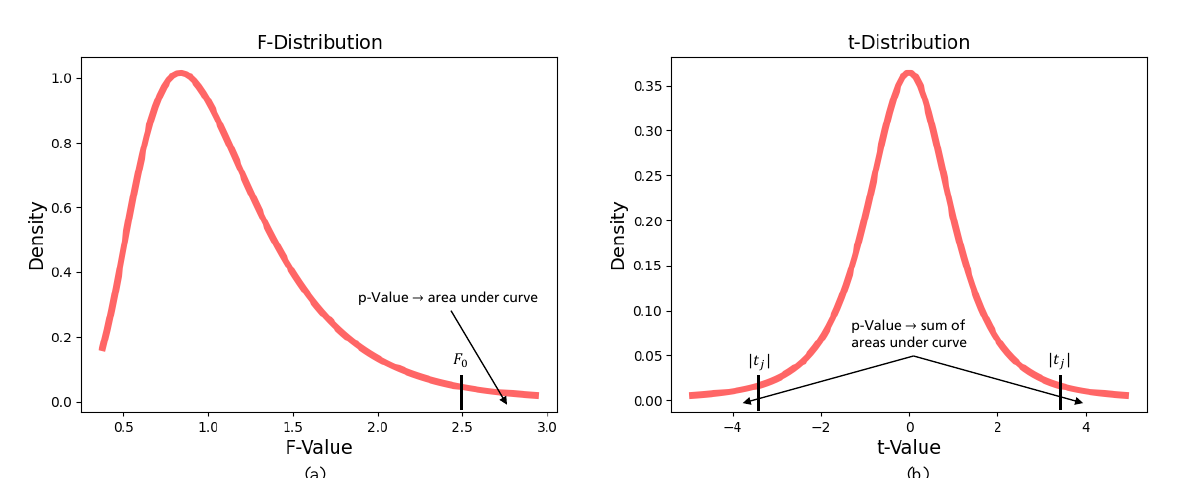
Figure 5 . Examples of an F-distribution (a) and a student’s t-distribution (b). The upper and lower line of the blue box, displayed in Figure 4, represent the upper and lower quartile, while the red middle line of the box marks the median. Additionally, the points situated at 1.5 IQR above and below the upper and lower quartile are marked with black whiskers. Any point situated outside these limits is represented by a red cross and is considered as an outlier. In the case of the semi-automatic outlier detection, the user can choose between three different approaches. A data point is considered as an outlier